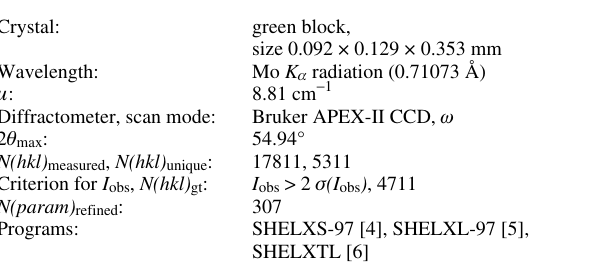
Table 1. Data collection and handling.